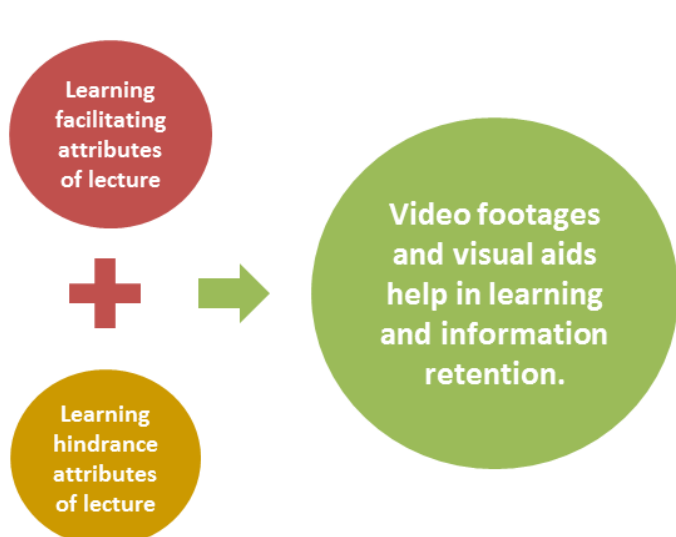
Figure 1 Video footages as a learning